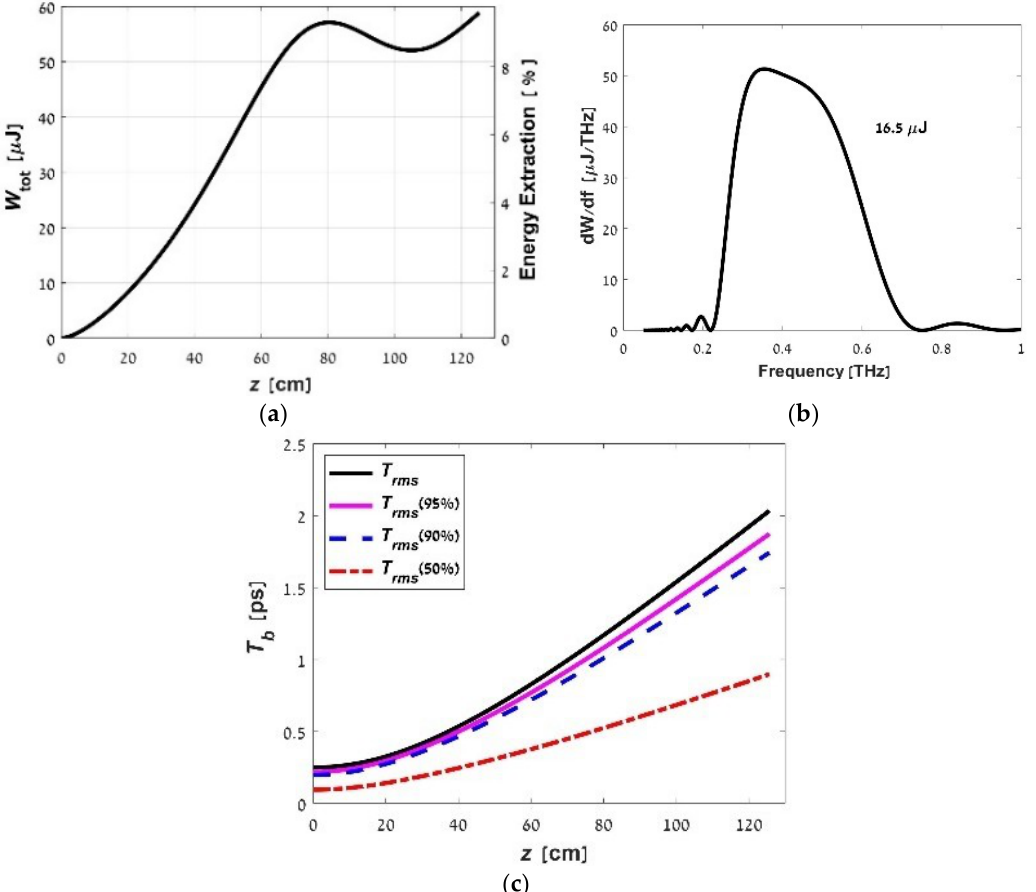
Figure 5. Cyclotron CSR of an electron bunch with a diameter of 1 mm, an initial duration of 0.25 ps, a charge of 0.1 nC, and a particle energy of 6 MeV in the group synchronism regime with the TE 11 mode: ( a ) radiated energy, ( b ) emission spectrum, and ( c ) change in the rms durations for all the bunch and for its central part (without a long tail of particles).